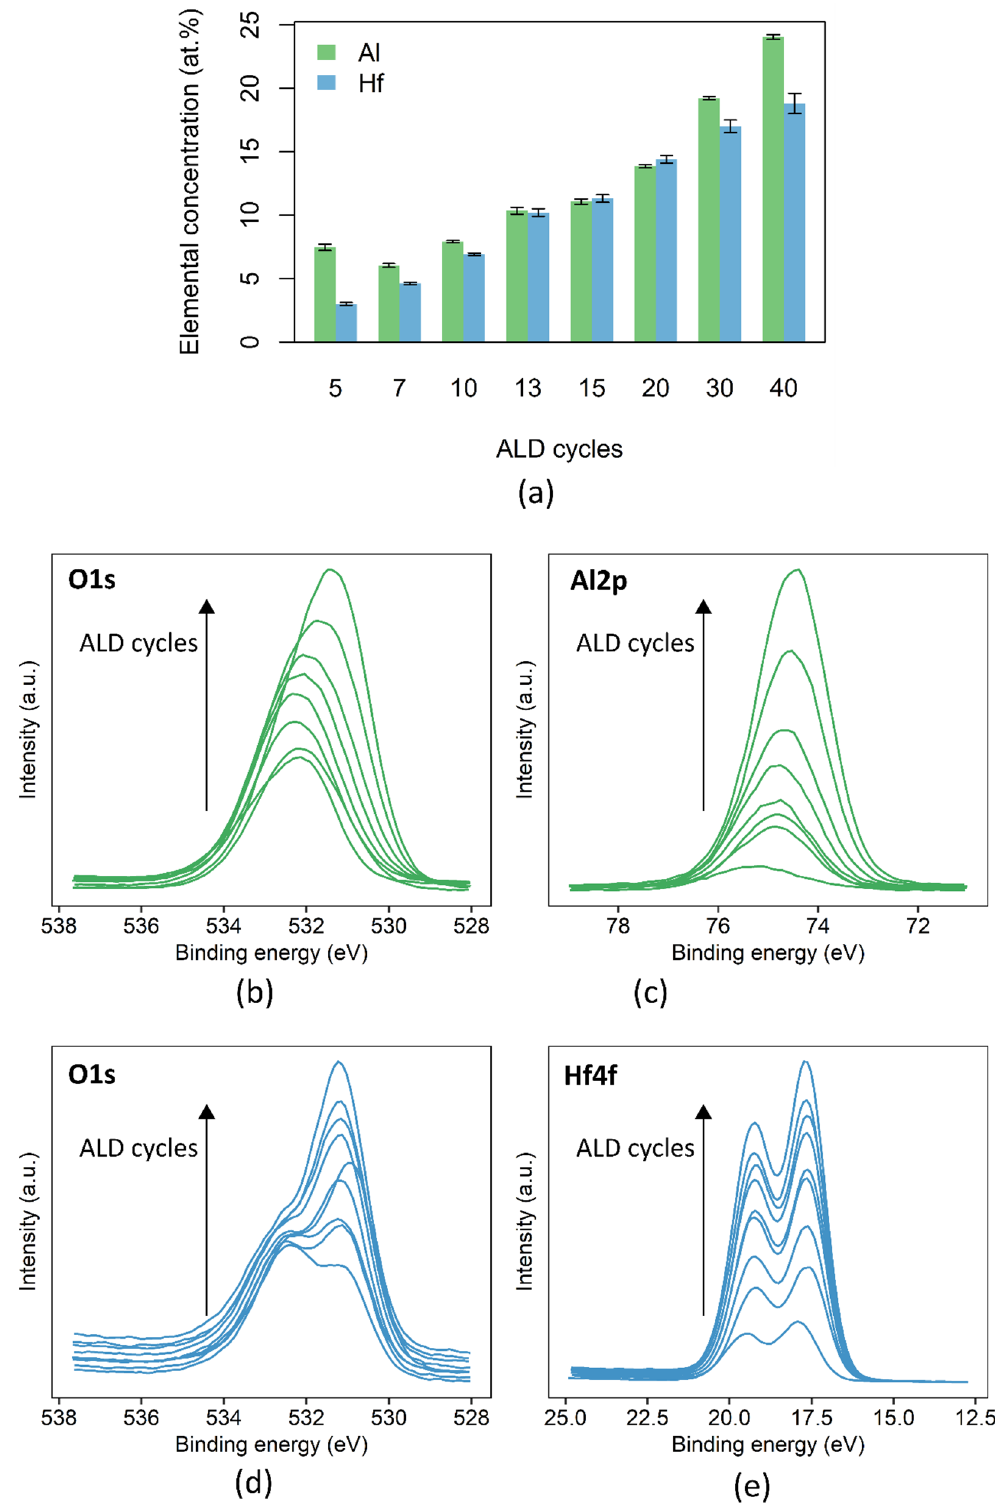
Figure 5. ( a ) Surface concentration of Al and Hf detected by XPS after the deposition of increasing Al 2 O 3 and HfO 2 ALD cycles, respectively, on polyimide. Evolution of ( b ) O1s and ( c ) Al2p high resolution peaks as successive Al 2 O 3 cycles were deposited on polyimide, from 5 to 40 cycles. Evolution of ( d ) O1s and ( e ) Hf4f high resolution peaks as successive HfO 2 cycles were deposited on polyimide, from 5 to 40 cycles. The arrows in ( b – e ) show the direction of increment of the deposited ALD cycles.